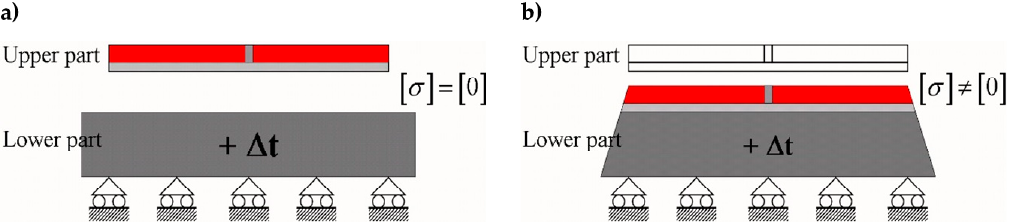
Figure 3. CM modeling of temperature variation in the sub-base of a radiant heat floor: Shape of the sub-domains ( a ) before and ( b ) after restoring compatibility between the sub-domains.